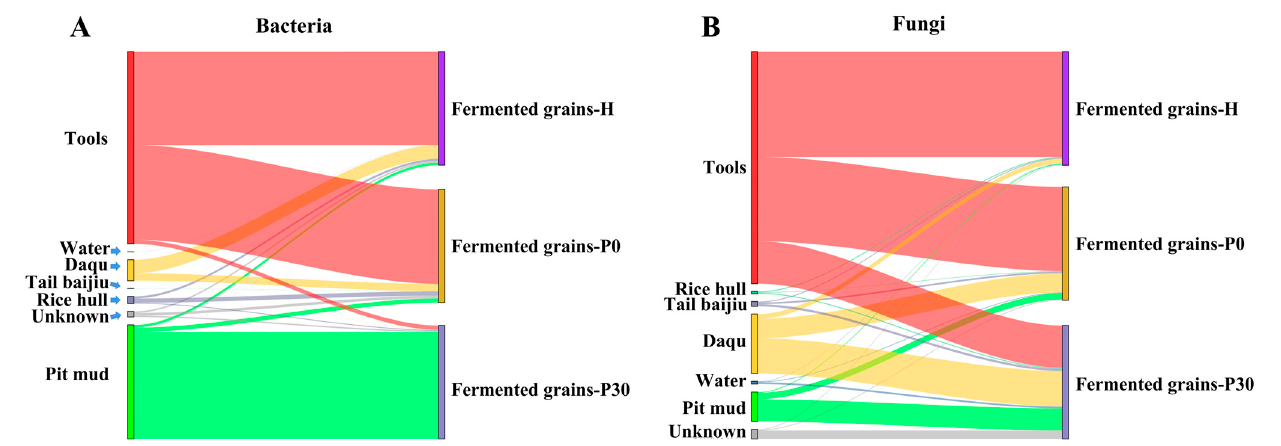
Figure 4. Microbial source estimation by Sourcetracker: ( A ) Source-tracking analysis of bacterial communities in fermented grains during the heap and pit fermentation of Sauce-flavor baijiu . ( B ) Source-tracking analysis of fungal communities in fermented grains during the heap and pit fermentation of Sauce-flavor baijiu